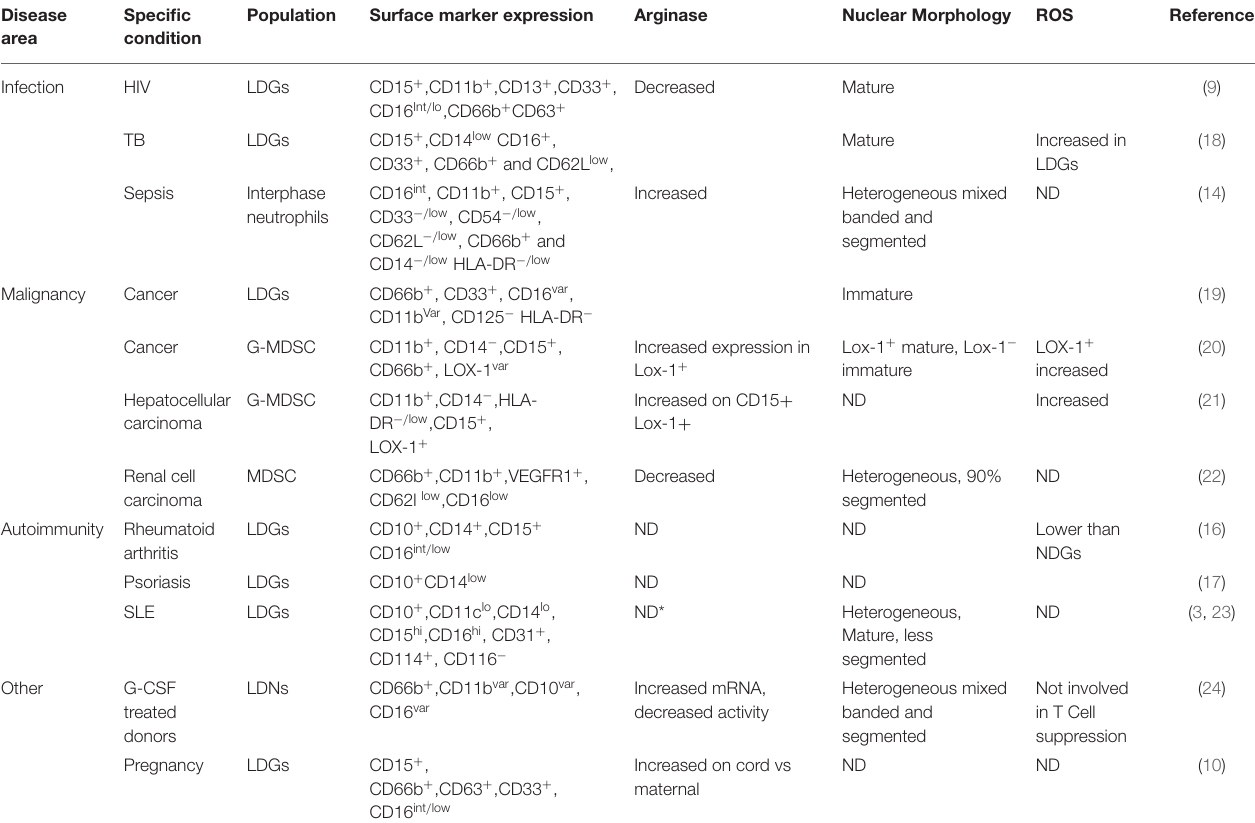
TABLE 1 | LDG population characteristics in various disease conditions. Disease